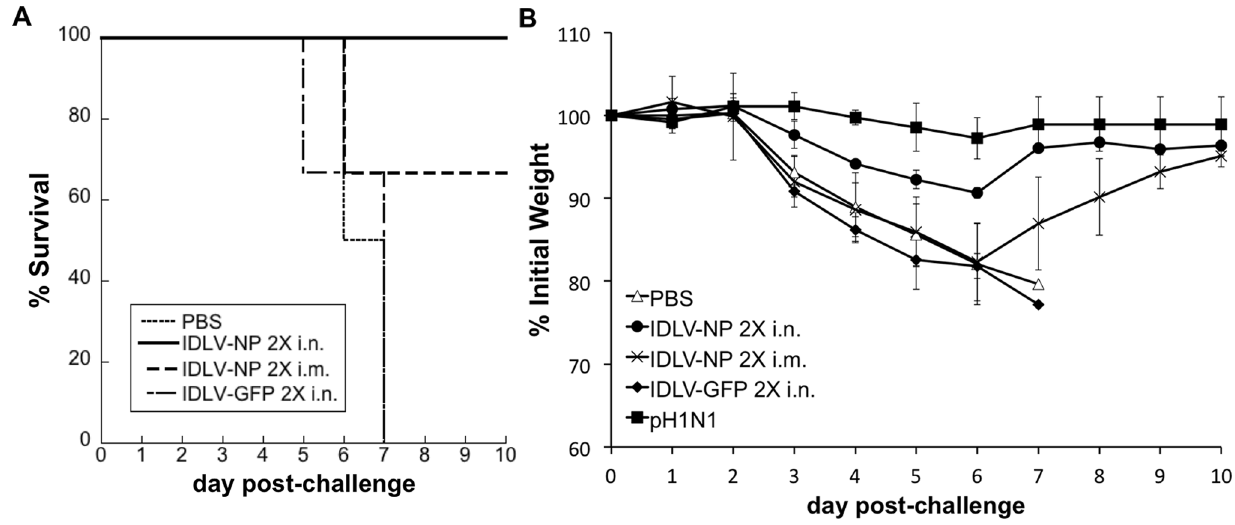
Figure 8. Immunization with IDLV-NP protects mice from challenge with a heterosubtypic influenza virus. Groups of mice (n=3) were inoculated with IDLV-NP 2 times i.n. or i.m., 4 weeks apart. Mice (n=3) that received PBS 2 times i.n. served as a negative control, mice (n=3) inoculated with 2 i.n. doses of IDLV-GFP, 4 weeks apart, served as a specificity control, and mice (n=3) that were infected with a sublethal dose of the mouse-adapted A/Netherlands/602/2009 (pH1N1) influenza virus served as a positive control for protection. Six weeks after the final administration, mice were challenged with a lethal dose ( . 10 LD 50 ) of pH1N1 influenza virus and monitored for survival ( A ) and weight loss ( B ). P-values calculated using pairwise group comparisons, at each time point, were based on the ANOVA test. For weight comparisons, Day 3: p , 0.05 IDLV-NP 2X i.n. versus PBS; p , 0.01 IDLV-NP 2X i.n. versus IDLV-GFP 2X i.n. or IDLV-NP 2X i.m.; Day 4: p , 0.05 IDLV-NP 2X i.n. versus PBS and IDLV-NP 2X i.m.; p , 0.005 IDLV- NP 2X i.n. versus IDLV-GFP 2X i.n.; Day 5, p , 0.05 IDLV-NP 2X i.n. versus IDLV-NP 2X i.m.; p=0.005 IDLV-NP 2X i.n. versus IDLV-GFP 2X i.n. Overall p- value for group comparisons based on the Kruskal-Wallis test: p=0.024 for day 3, p=0.029 for day 4, p=0.027 for day 5.